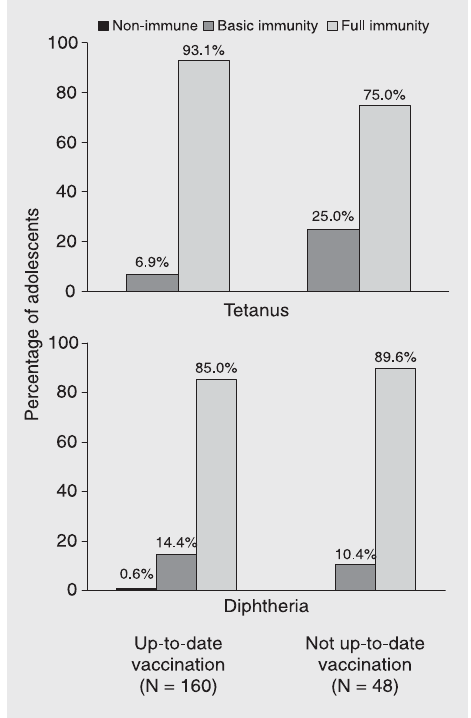
Figure 1. Immunity to tetanus and diphtheria in adolescents as a function of vaccination